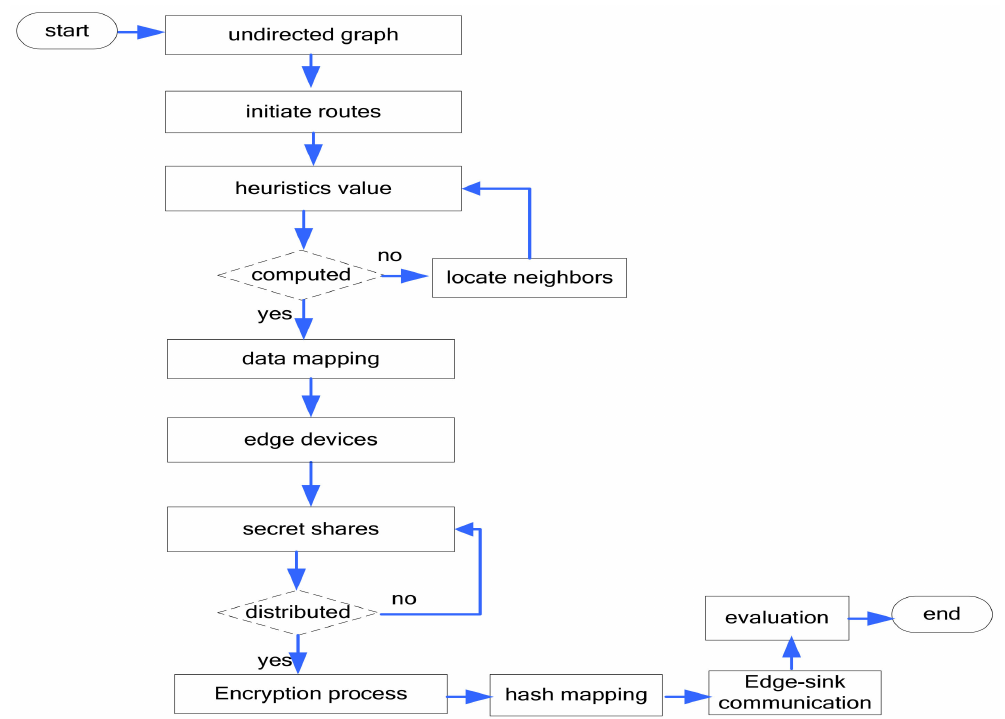
Figure 2. Flow chart of the proposed